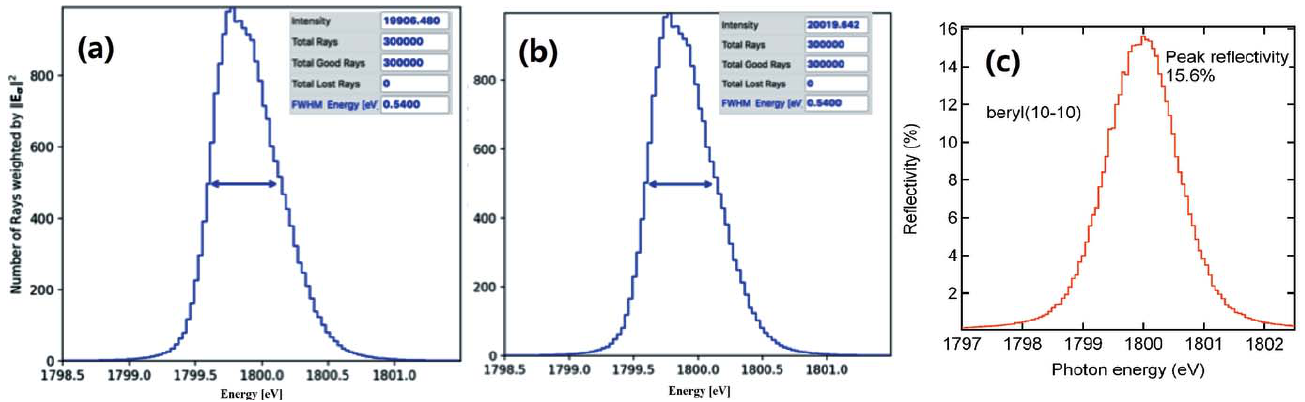
Figure 7 Ray-tracing plots in the OASYS suit for a DCM of InSb (111), using ( a ) the old and ( b ) the new format of SHADOW preprocessor files. ( c ) Peak reflectivity of a single beryl ð 10 (cid:3) 110 Þ crystal which is a normalized plot between the histogram intensity on the photon energy traced after a beryl crystal and that of the